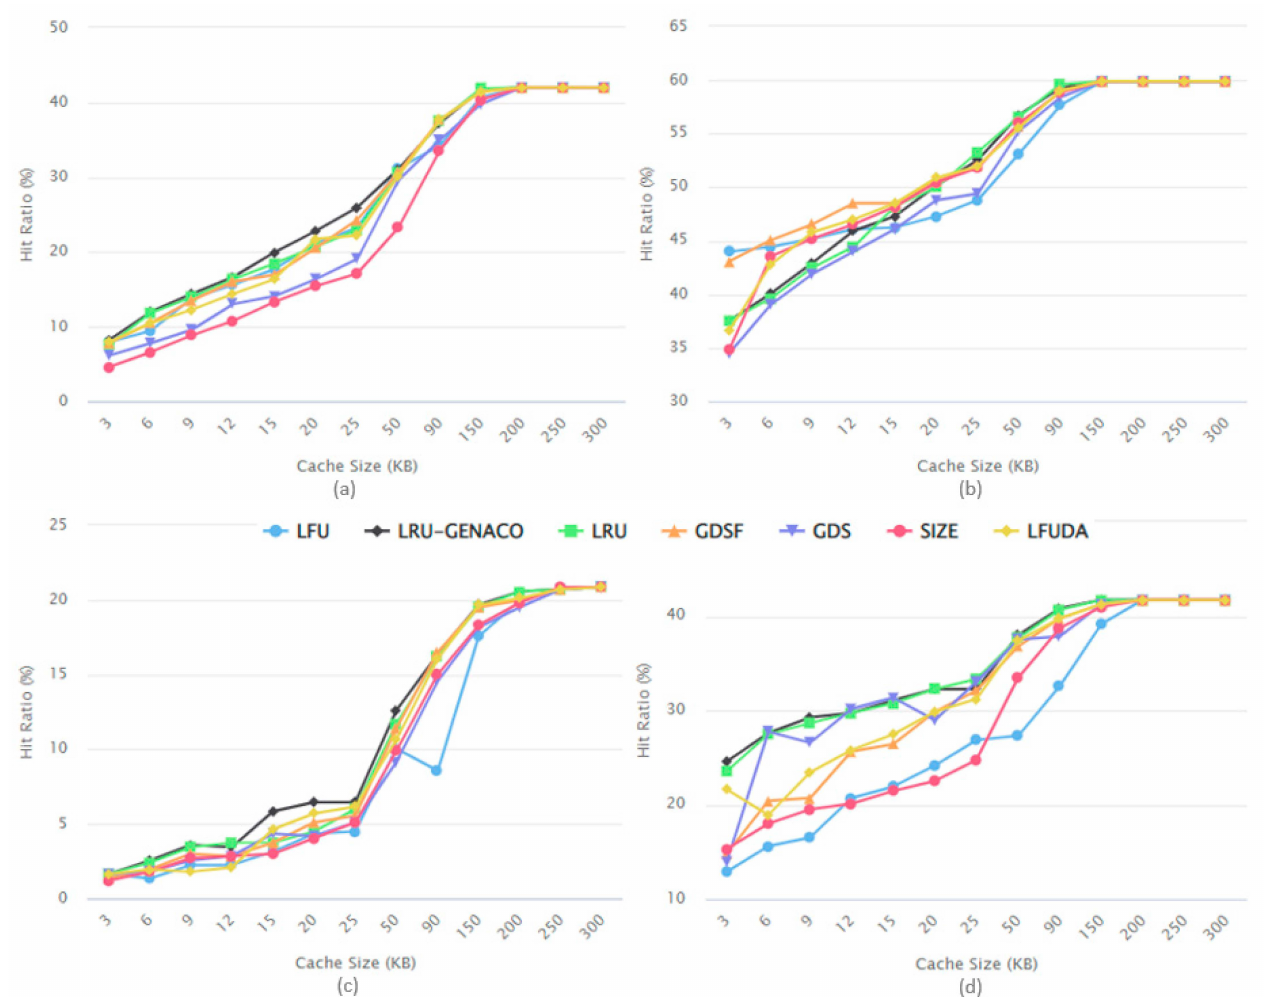
Figure 3. Impact of cache size on HR performance of four different datasets: ( a ) BO2; ( b ) NY; ( c ) SV; and ( d ) UC.